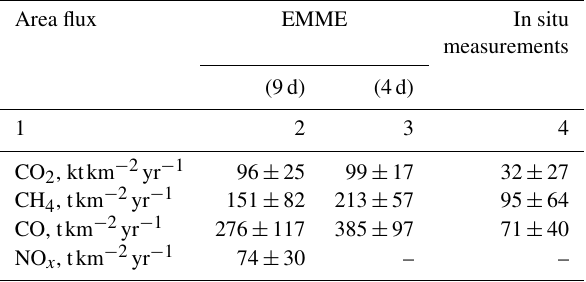
Table B1. Area fluxes for CO 2 (ktkm − 2 yr − 1 ), CH 4 (tkm − 2 yr − 1 ),